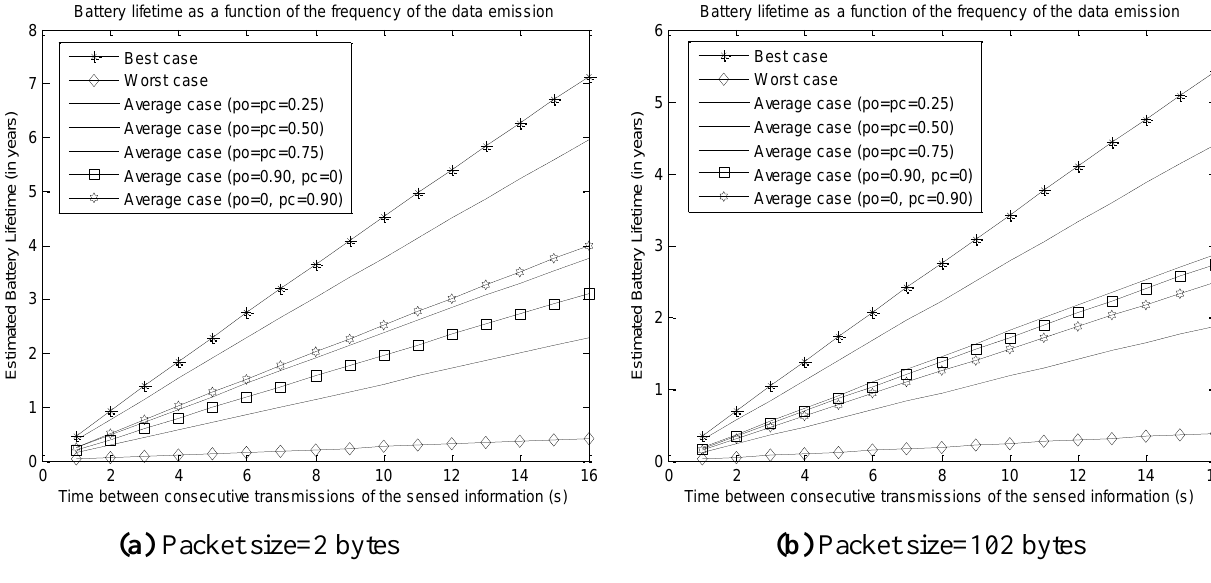
Figure 9. Comparison of the expected battery lifetimes for the different analyzed cases and different probabilities of CCA failure ( p is 1,200